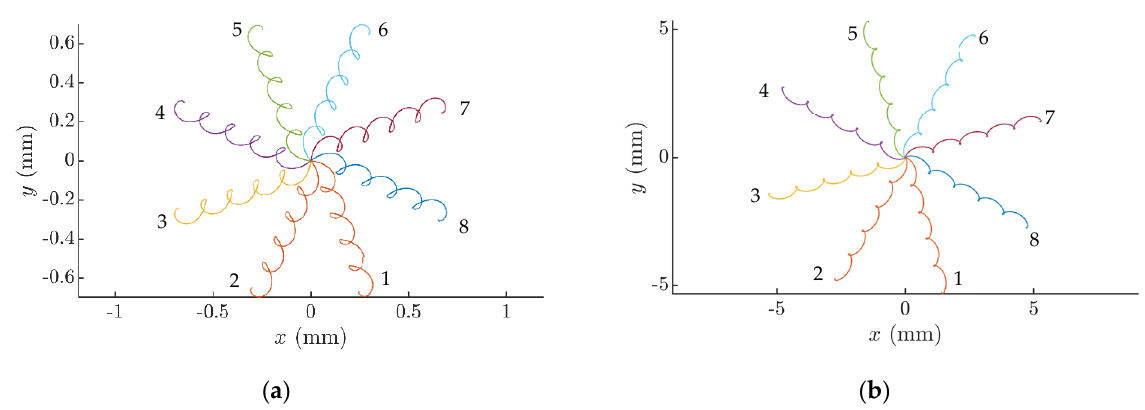
Figure 5. Trajectories of the part at different values of the phase shift ϕ when μ 1 = 0.12, μ 2 = μ 1 /8, g = 9.81 m/s 2 , A e = 0.28 mm, ω = 62.8 rad/s, ε = π /2, (1), ϕ = 0, (2), ϕ = π / 4; (3), ϕ = π / 2; (4) , ϕ = 3 π / 4; (5) , ϕ = π ; (6) , ϕ = 5 π / 4; (7), ϕ = 3 π / 2; (8), ϕ = 7 π / 4: ( a ) as Δ τ = π /6; ( b ) as Δ τ = π .